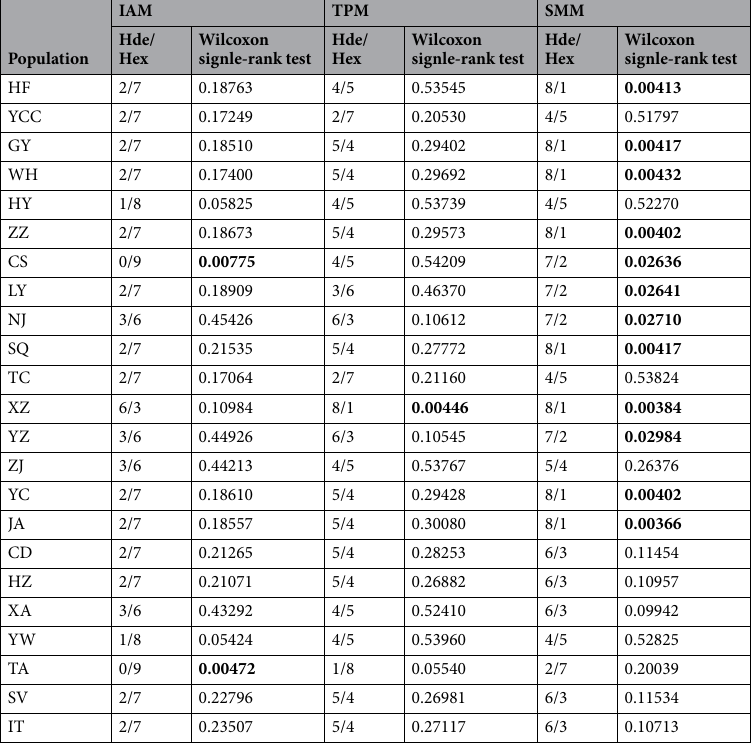
Table 7. Bottleneck test for Corythucha ciliata based on microsatellites. Hde, heterozygote deficiency; Hex, heterozygote excess. Bold indicates p <